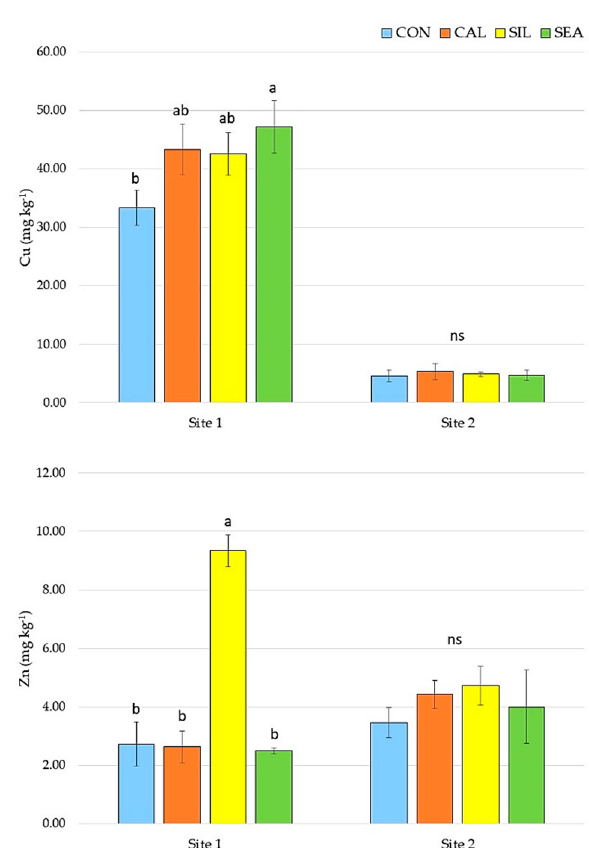
Figure 2. E ff ect of the biostimulants on copper (above) and zinc (below) content in apples harvested in Site 1 and Site 2. Vertical bars indicate means ± SD ( n = 3). Within each site, letters indicate significant di ff erences according to Tukey’s HSD post-hoc test; p < 0.05 (ns: not significant).